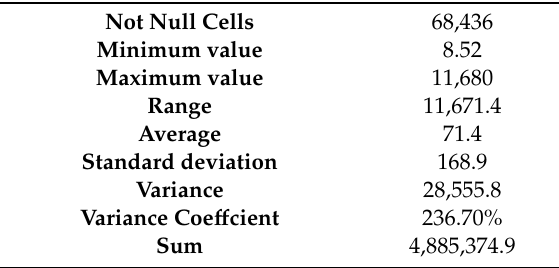
Table 3. Univariate Statistics of Soil Loss raster map.